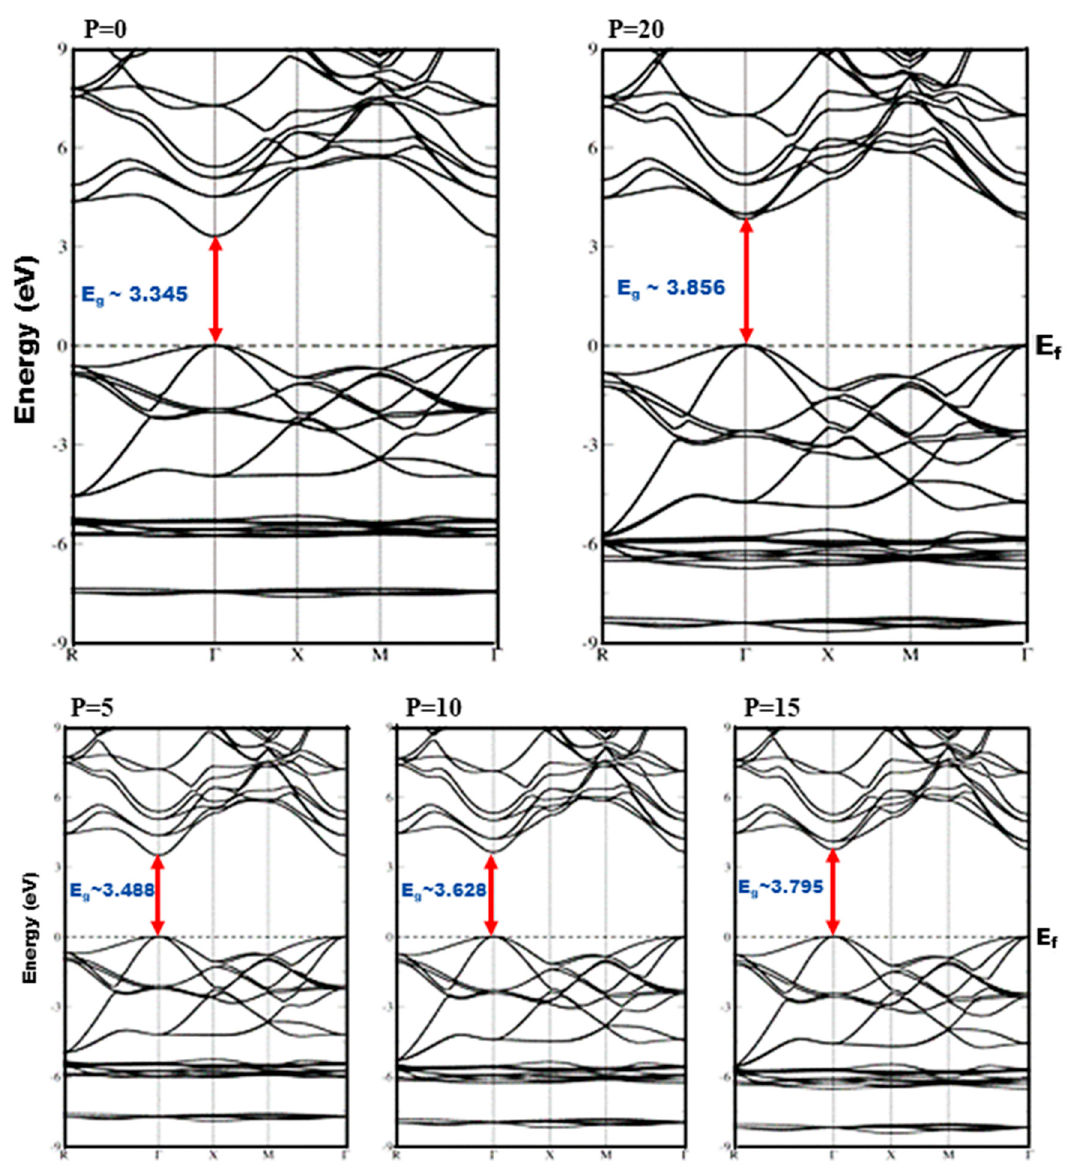
Figure 2. Band structures of Cd 0.25 Zn 0.75 S alloy computed within mBJ at pressures ranging from 0 to 20 GPa.